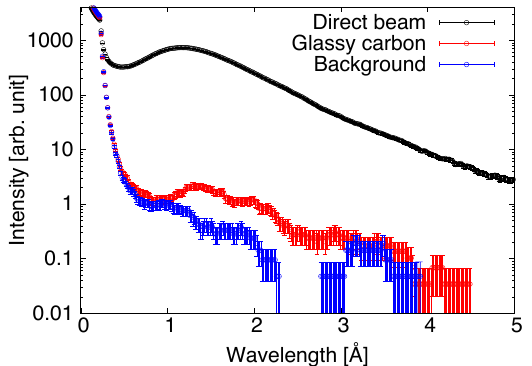
Fig. 2. TOF spectra of the direct beam, the scattered neutron from glassy carbon and the background measurements